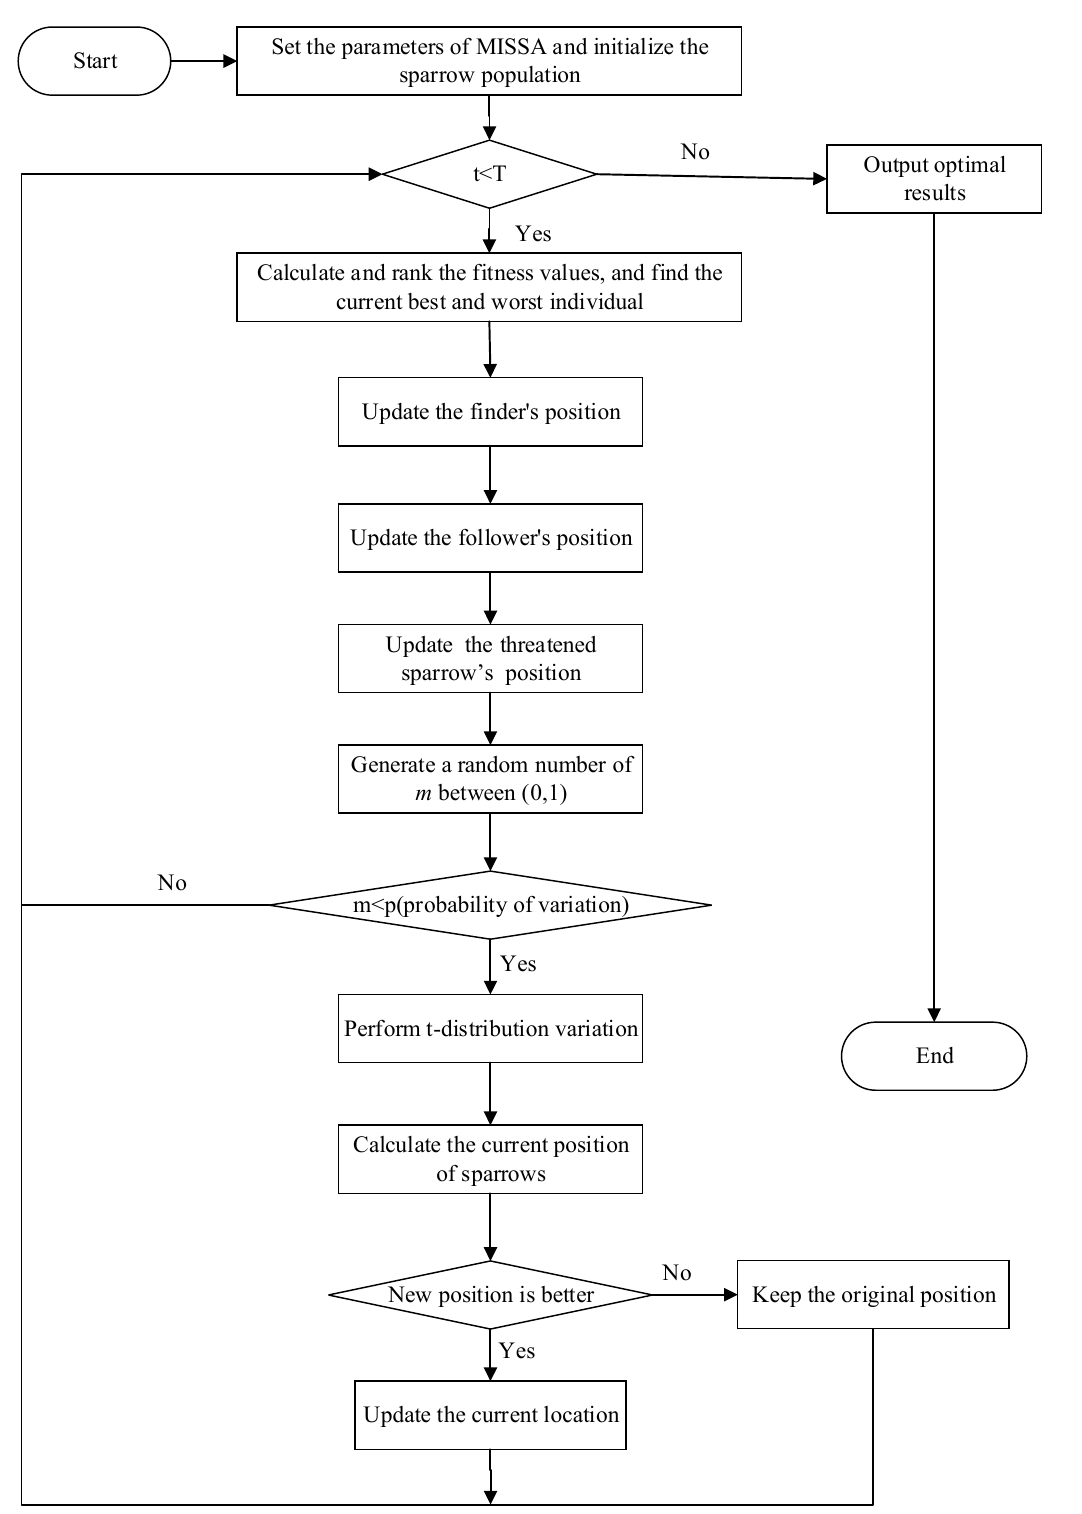
Figure 4. Flow chart of MISSA.